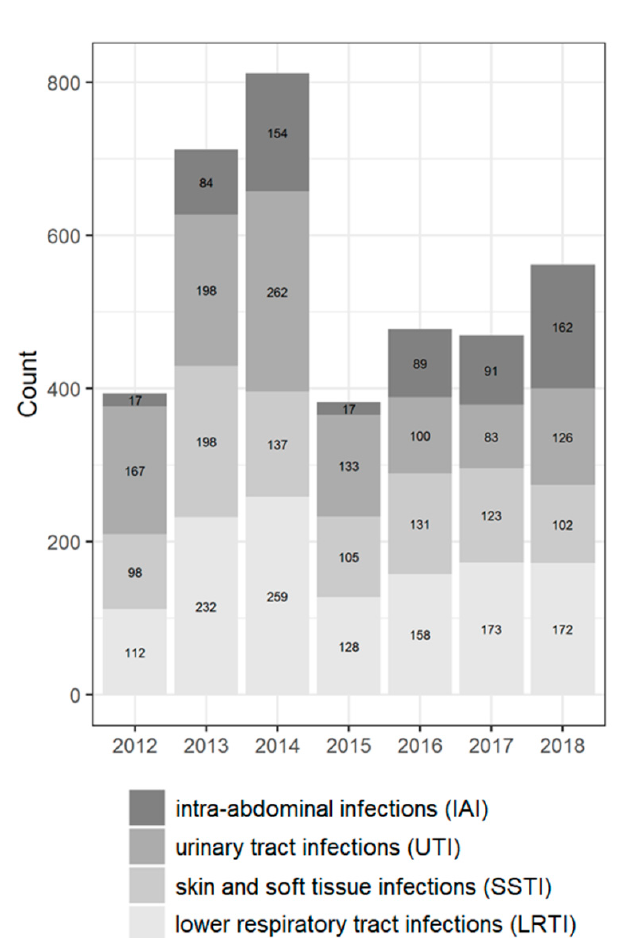
Figure 1. Distribution of the isolates according to source of infection by years (the absolute number and percentage of isolates for different years).